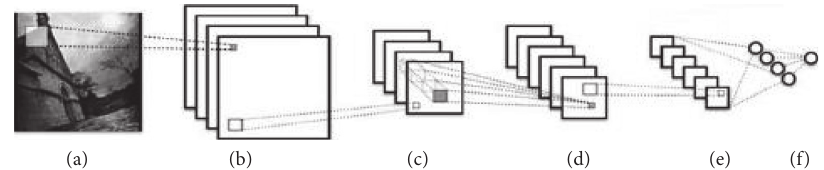
Figure 1: The basic structure of CNN. (a) Input layer I. (b) Layer C1. (c) Layer S1. (d) Layer C2. (e) Layer S2. (f) Output.